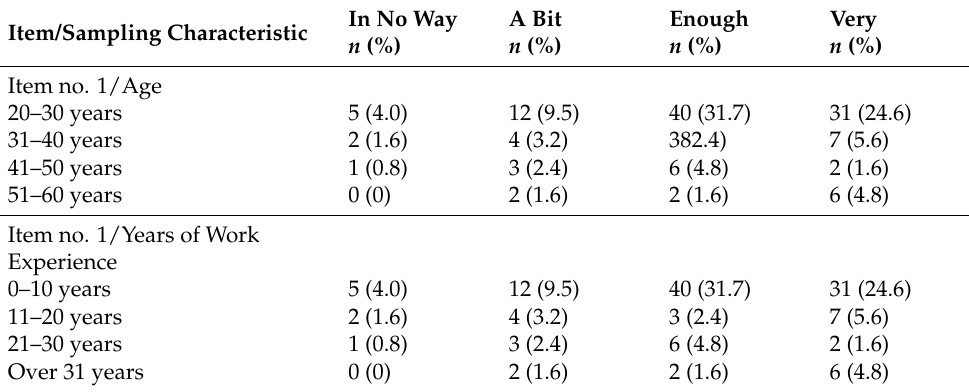
Table 4. How varied significant associations between the groups